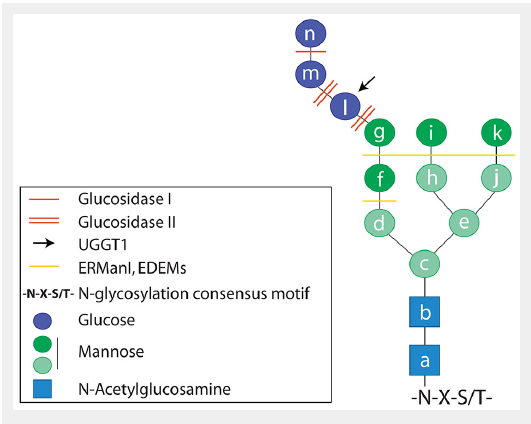
Figure 1 Structure of the N-linked oligosaccharide. The oligosaccharide is covalently bound to the side chain of asparagine residues in asparagine(N)-any aminoacid(X)-serine(S) or threonine(T) consensus